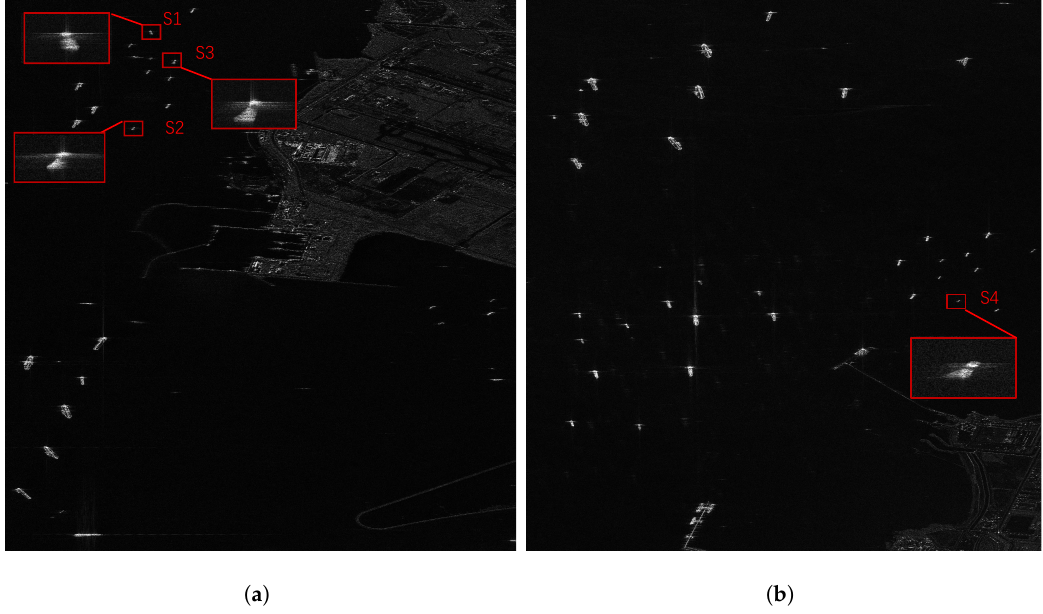
Figure 8. Gaofen-3 images of Singapore. ( a ) Image location: (E104.0, N1.3). ( b ) Image location: (E104.1,